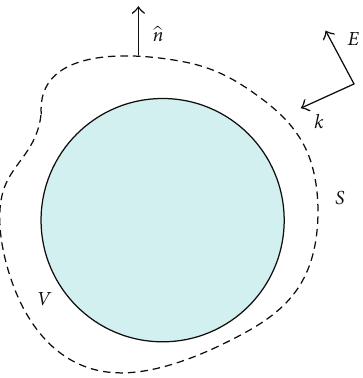
Figure 1: The 3D electromagnetic scattering problem by the FEM-